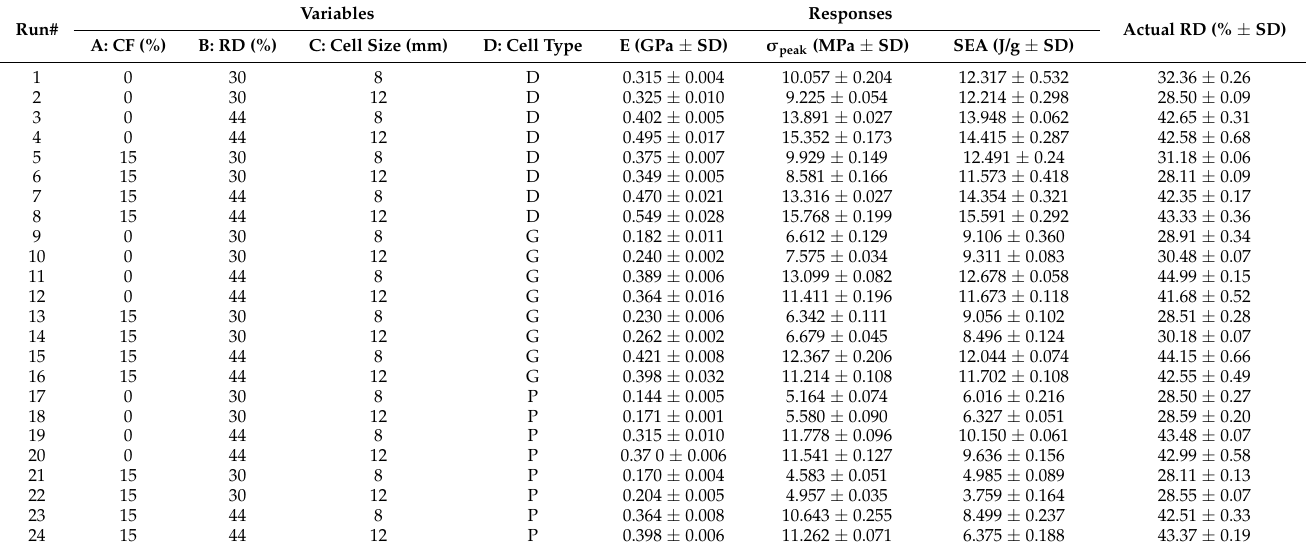
Table 4. Full factorial experiments along with the results (E, σ peak , SEA, and actual